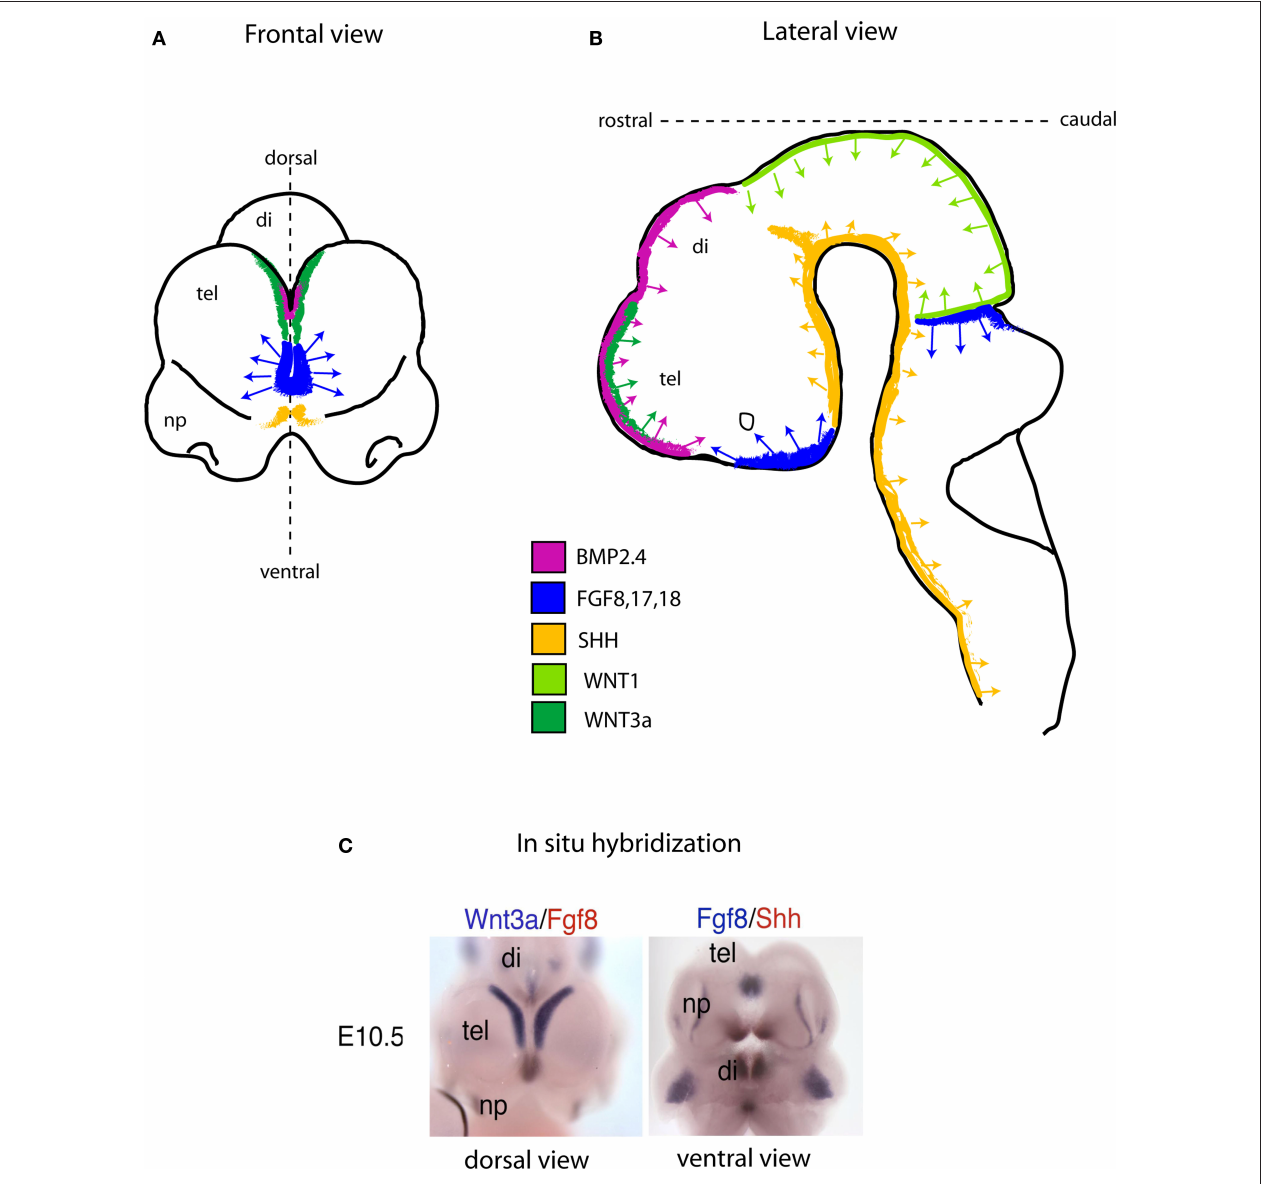
the ventral SHH source (yellow). As in the forebrain, the same or similar signaling molecules direct neural tube patterning and NSC development in the remainder of the CNS (B) . (C) , Dual probe in situ hybridization data exemplifying the schematic drawn in (A) in a mouse embryo at the age of E10.5. Abbreviations: tel, telencephalon; di, diencephalon; np, nasal